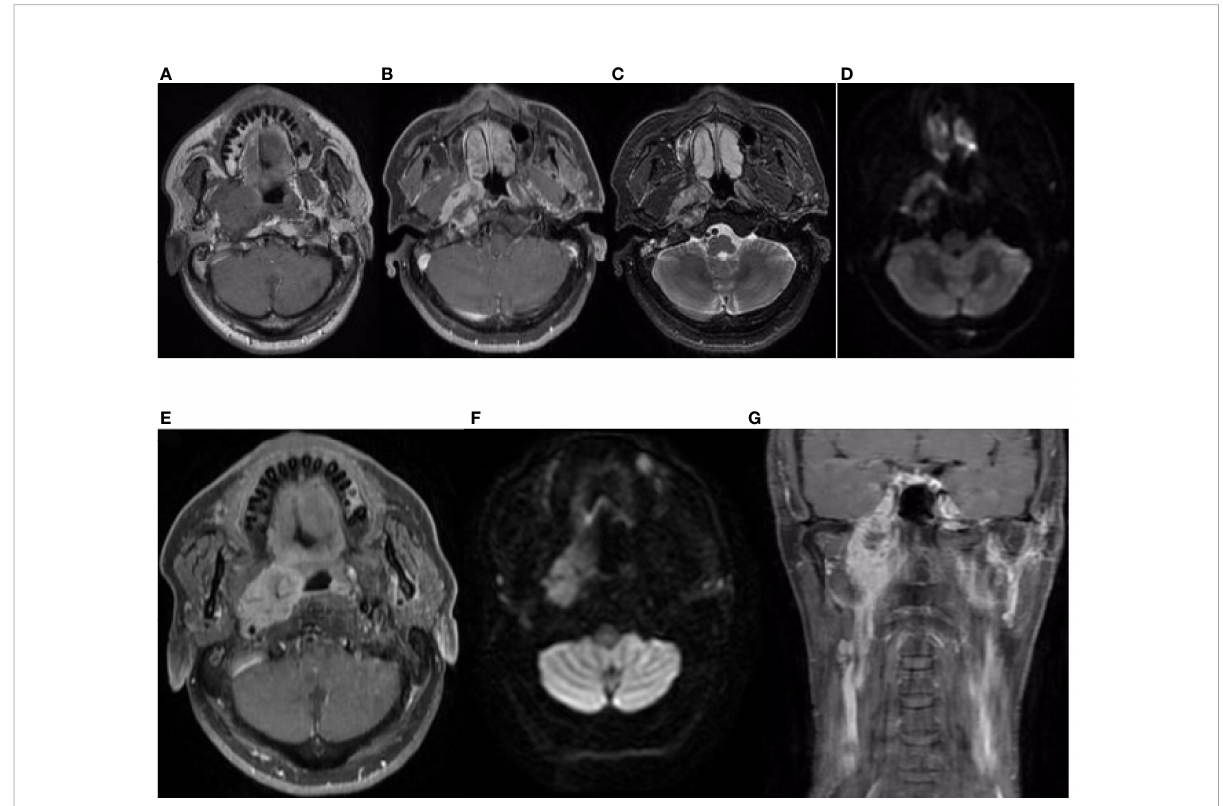
FIGURE 1 Nasopharynx and neck MRI fi ndings from 15 April 2019. (A – D) The axial planes of T1-weighted, enhanced T1-weighted, T2-weighted, and diffusion-weighted imaging (DWI) MRI of the nasopharynx, showing a 5.6 cm × 3.4 cm × 3.1 cm mass within the right parietal and lateral walls of the nasopharynx, accompanied by skull base bone invasion, invasion of the oropharyngeal lateral wall and right parapharyngeal space, the right medial pterygoid muscle, and the musculus longus capitis. (E, F) The axial planes of enhanced T1-weighted DWI MRI revealed enlargement of the right retropharyngeal lymph node. (G) The coronal plane of enhanced T1-weighted imaging showed tumor involvement with the cavernous